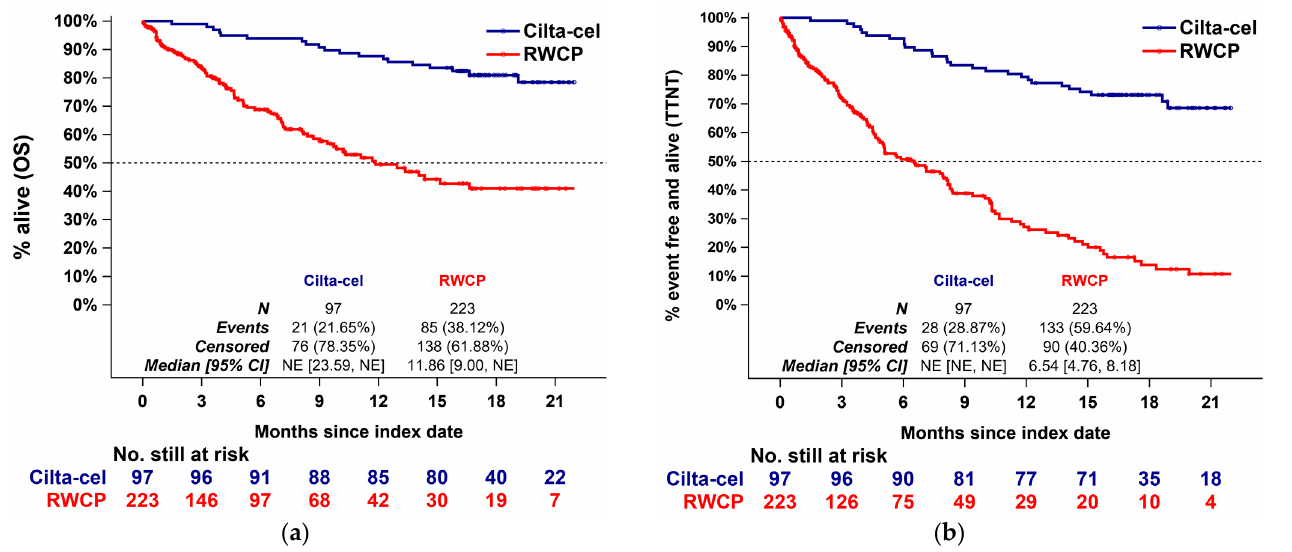
Figure 4 . Unadjusted Kaplan–Meier Curves, OS and TTNT. Unweighted Kaplan–Meier curves in the cilta-cel and RWCP groups for the mITT population are shown for ( a ) OS and ( b ) TTNT. As these graphs present the unadjusted Kaplan–Meier curves, any differences in baseline characteristics as described in Figure 3 are not accounted for. For results of the adjusted comparisons, Figure 2 should be considered. Abbreviations: CI, confidence interval; OS, overall survival; NE, not estimable (not reached); RWCP, real world clinical practice; TTNT, time to next treatment.